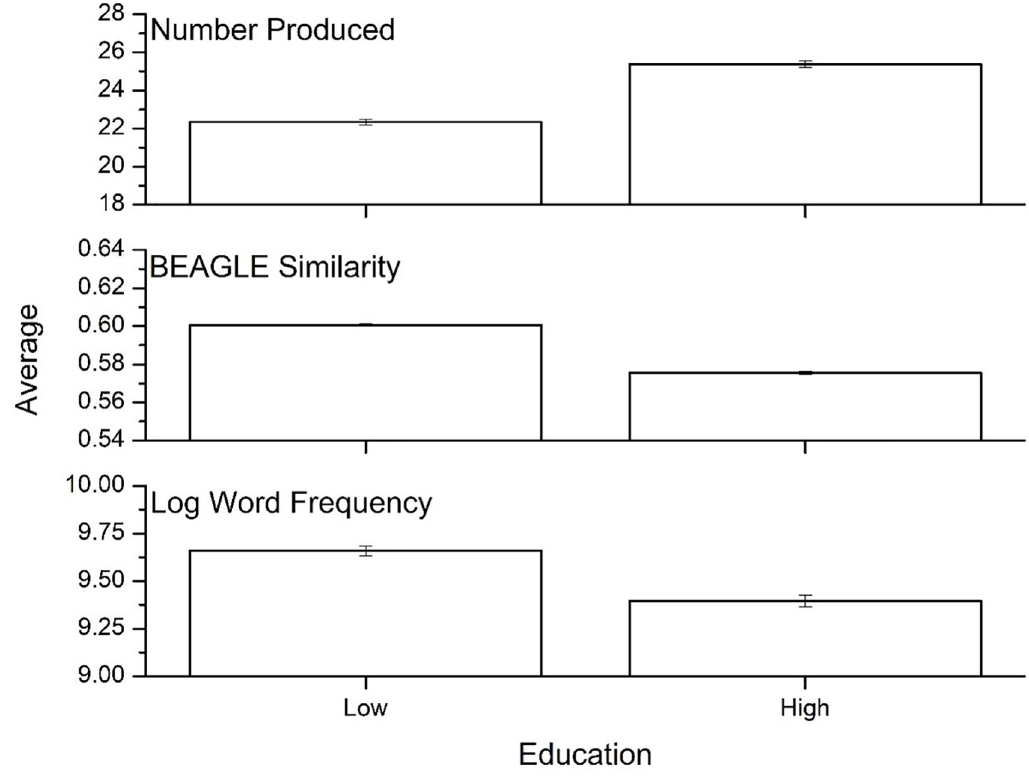
Fig 4. Means for the three psycholinguistic variables by education level. Error bars represent 95% confidence intervals.